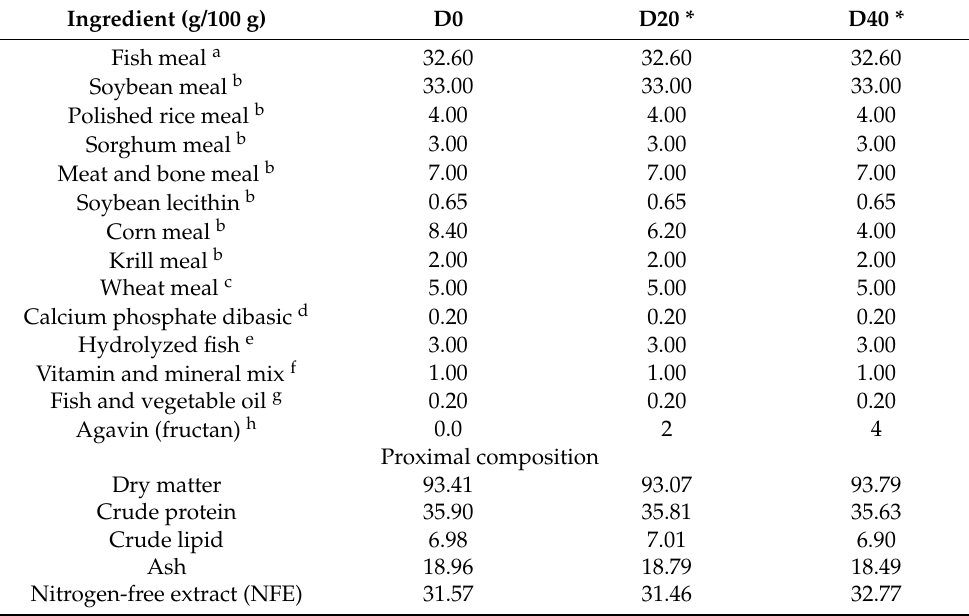
Table 1. Formulation and chemical composition of the experimental